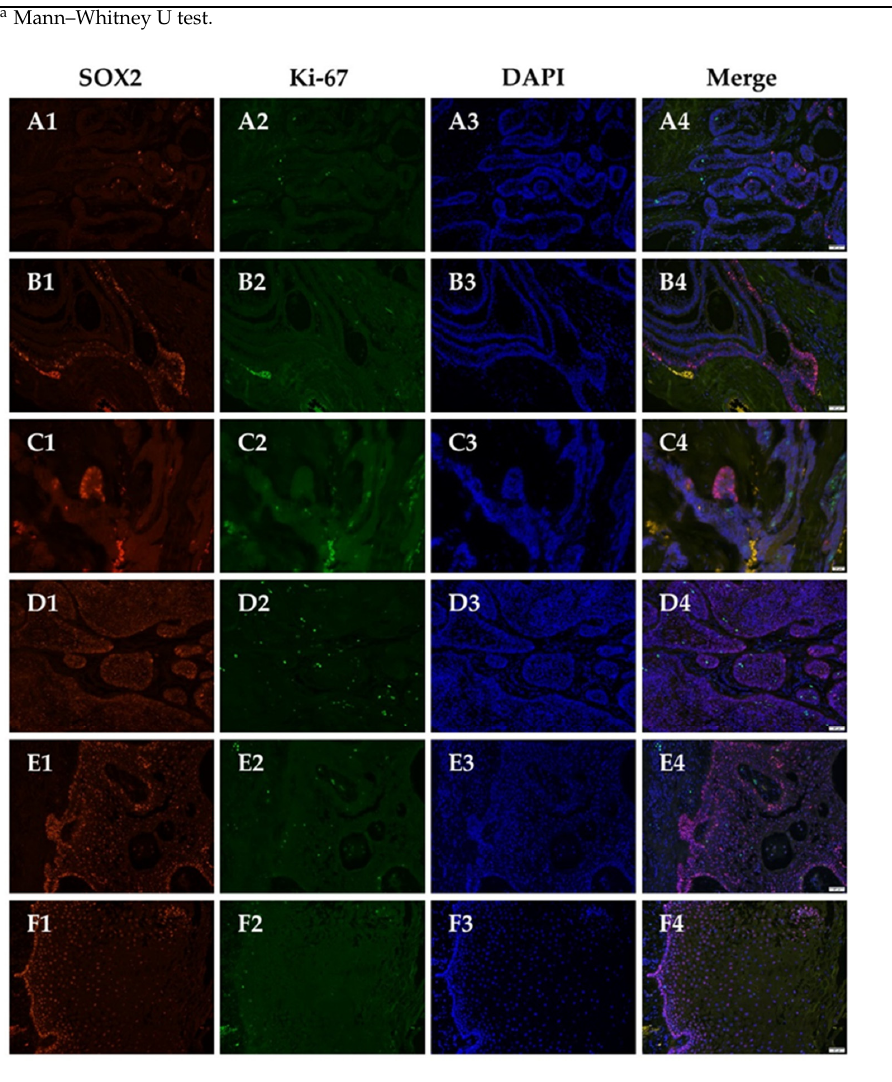
Figure 4. Immunofluorescence for SOX2 and Ki-67. Confirming SOX2+ and Ki-67+ cells were in different population of tumor cells. ( A ) Follicular type; ( B , C ) plexiform type; ( D ) follicular type with soft tissue invasion; ( E ) plexiform type with heavy inflammation; ( F ) oral squamous epithelium. (Original magnification ×200; C series: ×400).